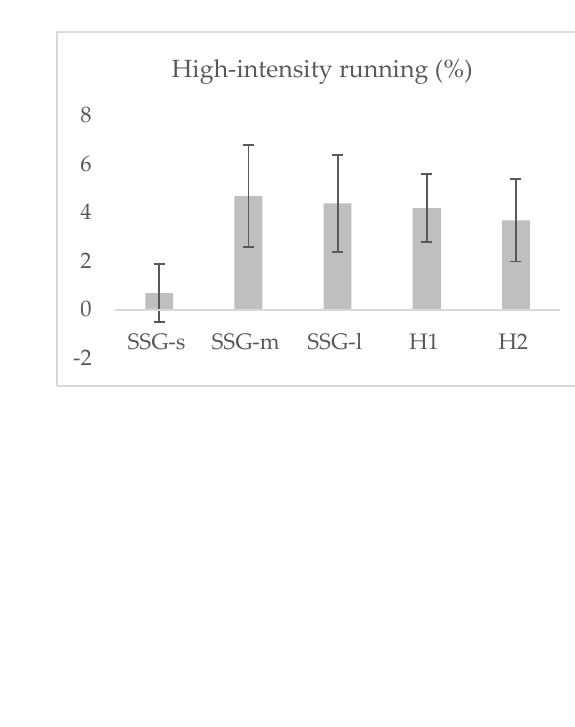
12.9 km·h −1 ; Medium-intensity running: distance covered between 13 – 17.9 km·h −1 ; High-intensity tween 7.0–12.9 km · h − 1 ; Medium-intensity running: distance covered between 13–17.9 km · h − 1 ; running: distance covered between 18 – 20.9 km·h −1 ; Sprinting: distance covered >21 km·h −1 . SSG-l: High-intensity running: distance covered between 18–20.9 km · h − 1 ; Sprinting: distance small-sided games large; SSG-m (small-sided games medium), SSG-s (small-sided games small). covered >21 km · h − 1 . SSG-l: small-sided games large; SSG-m (small-sided games medium), SSG-s H1: First half; H2: Second half. (small-sided games small). H1: First half; H2: Second